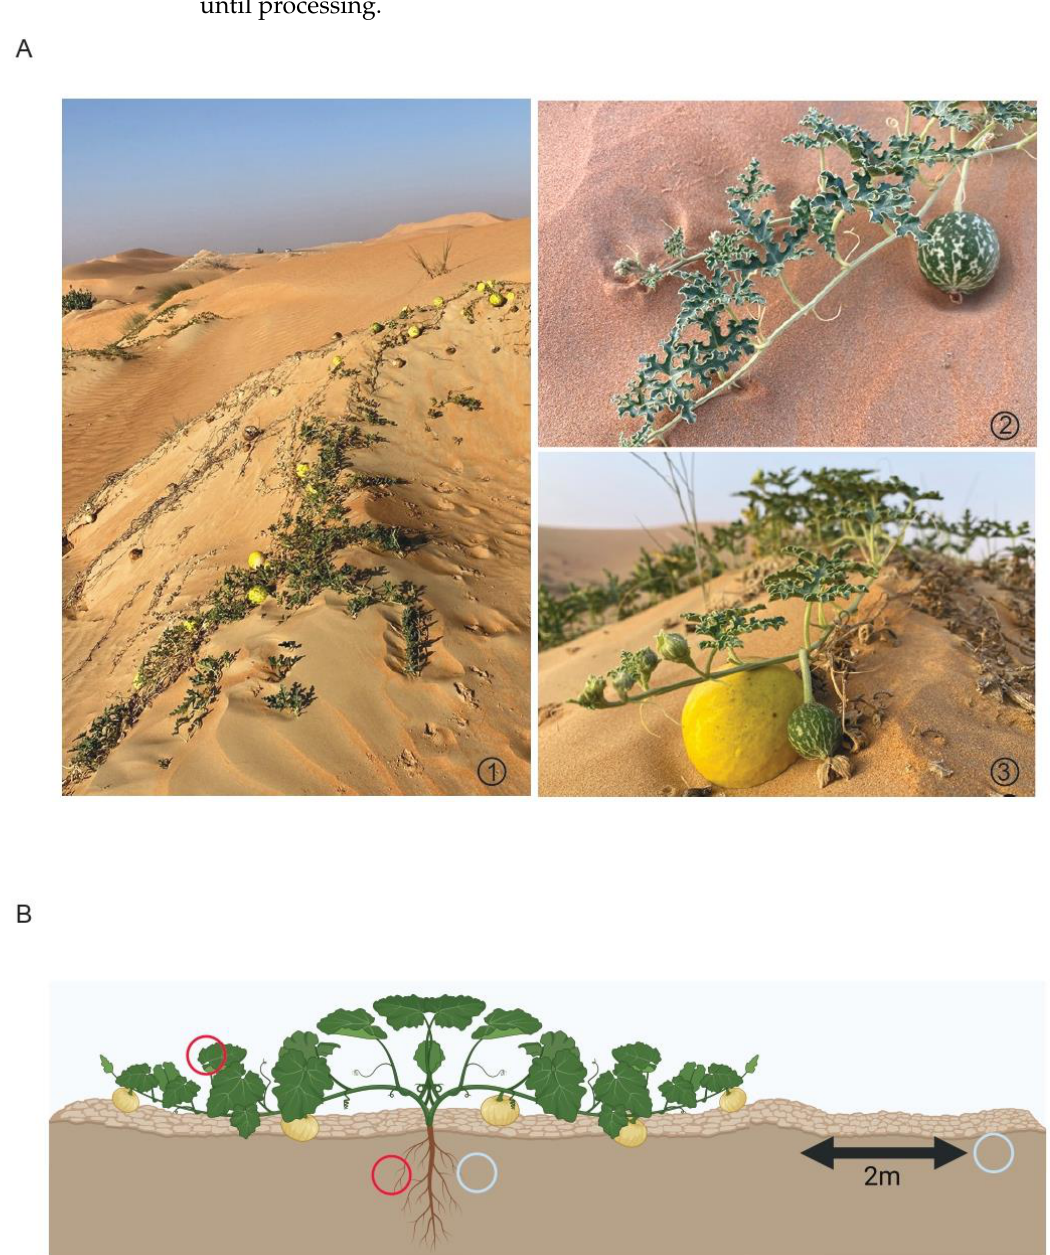
Figure 1. ( A ) Citrullus colocynthis . The new season’s growth emerges between dried and dead vines from the previous season (1). Immature fruits are green with irregular white “stripes” (2) and newly developing fruit can be seen alongside mature, yellow fruit from the previous season (3). ( B ) Over- view of the different samples collected from C. colocynthis plants. Red circles represent plant samples, while blue circles represent root zone (closest to roots) and bulk soil (2 m from plant) samples. The image was created with BioRender.com (accessed on 21 September 2022).